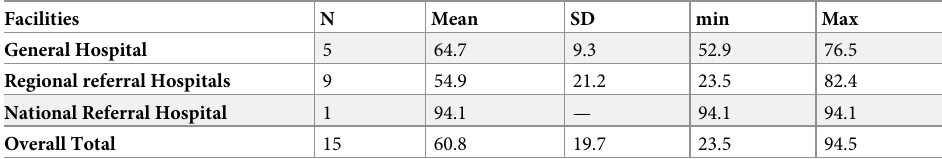
Table 1. Summary statistics for total percentage adherence score per facility type.